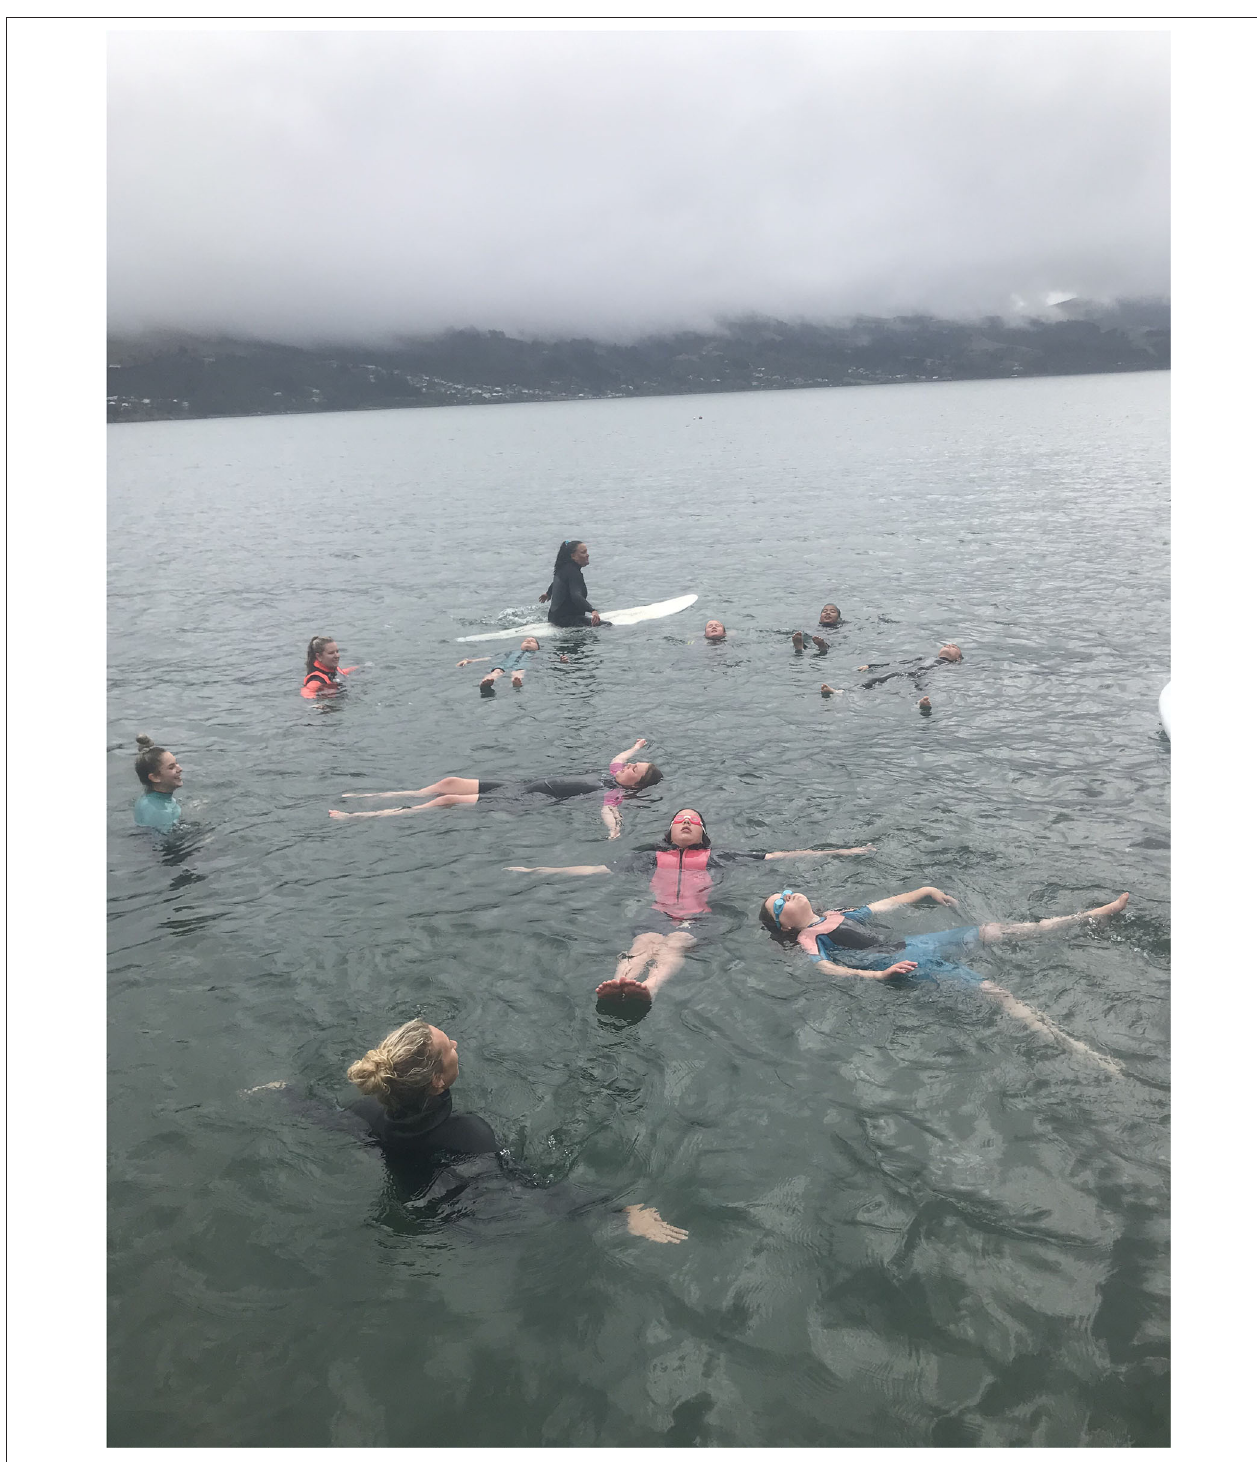
FIGURE 2 | Children learning how to float in an outdoor environment, under close supervision. and Latino children are 2–8 times more likely to drown compared with white children from the same countries (Olaisen et al.,